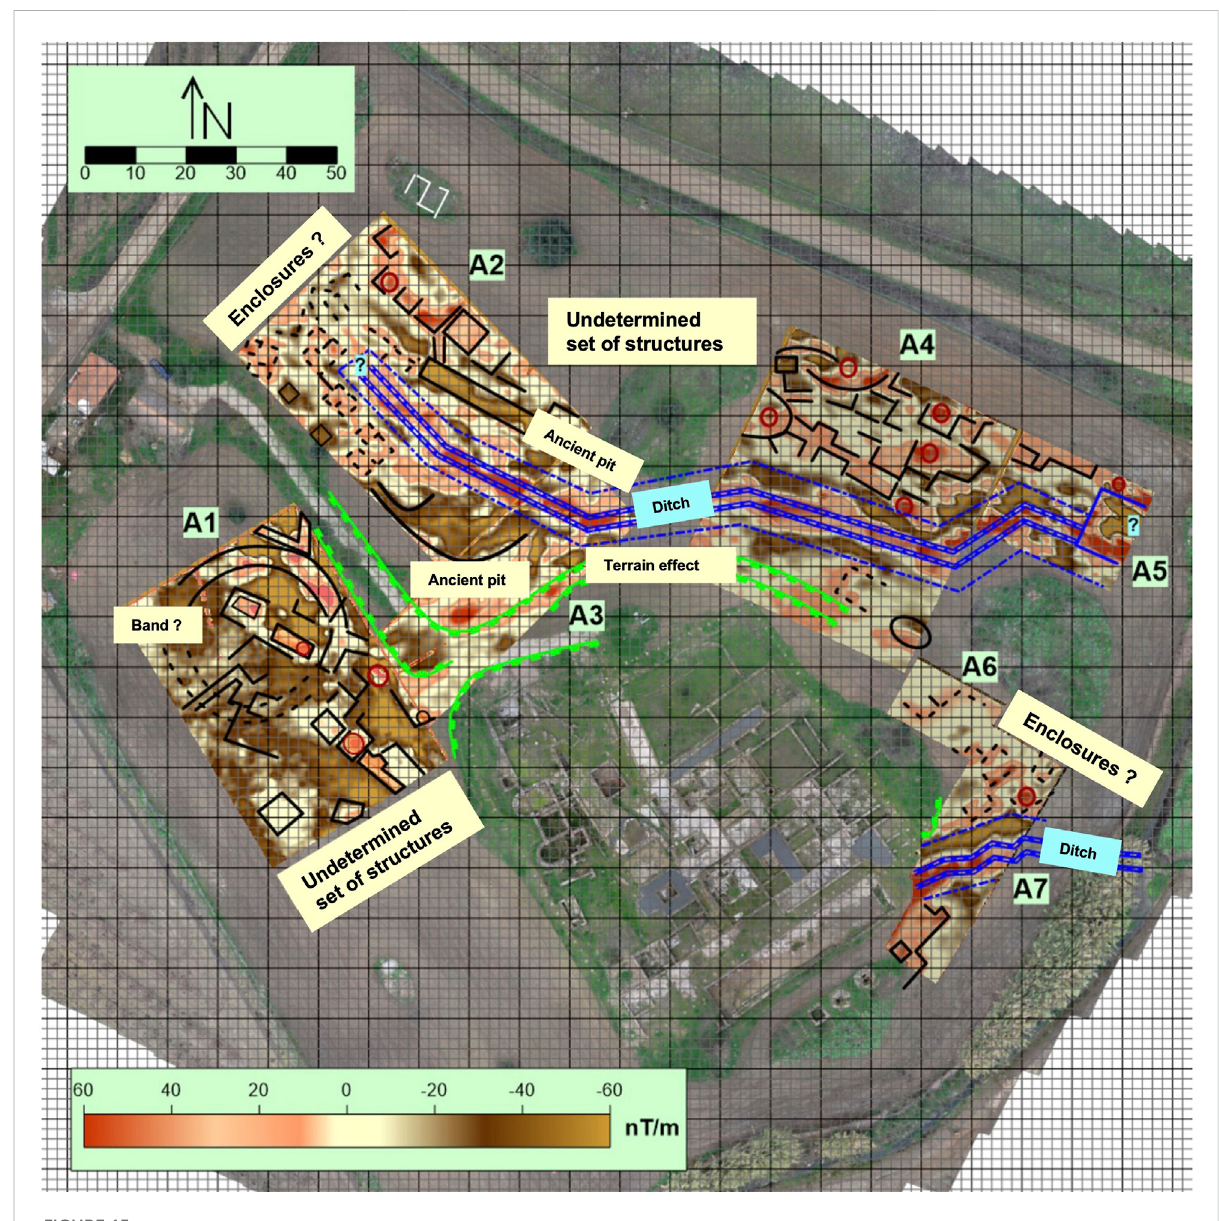
FIGURE 15 Interpretation of the geophysical prospection on the orthophoto of Villa of